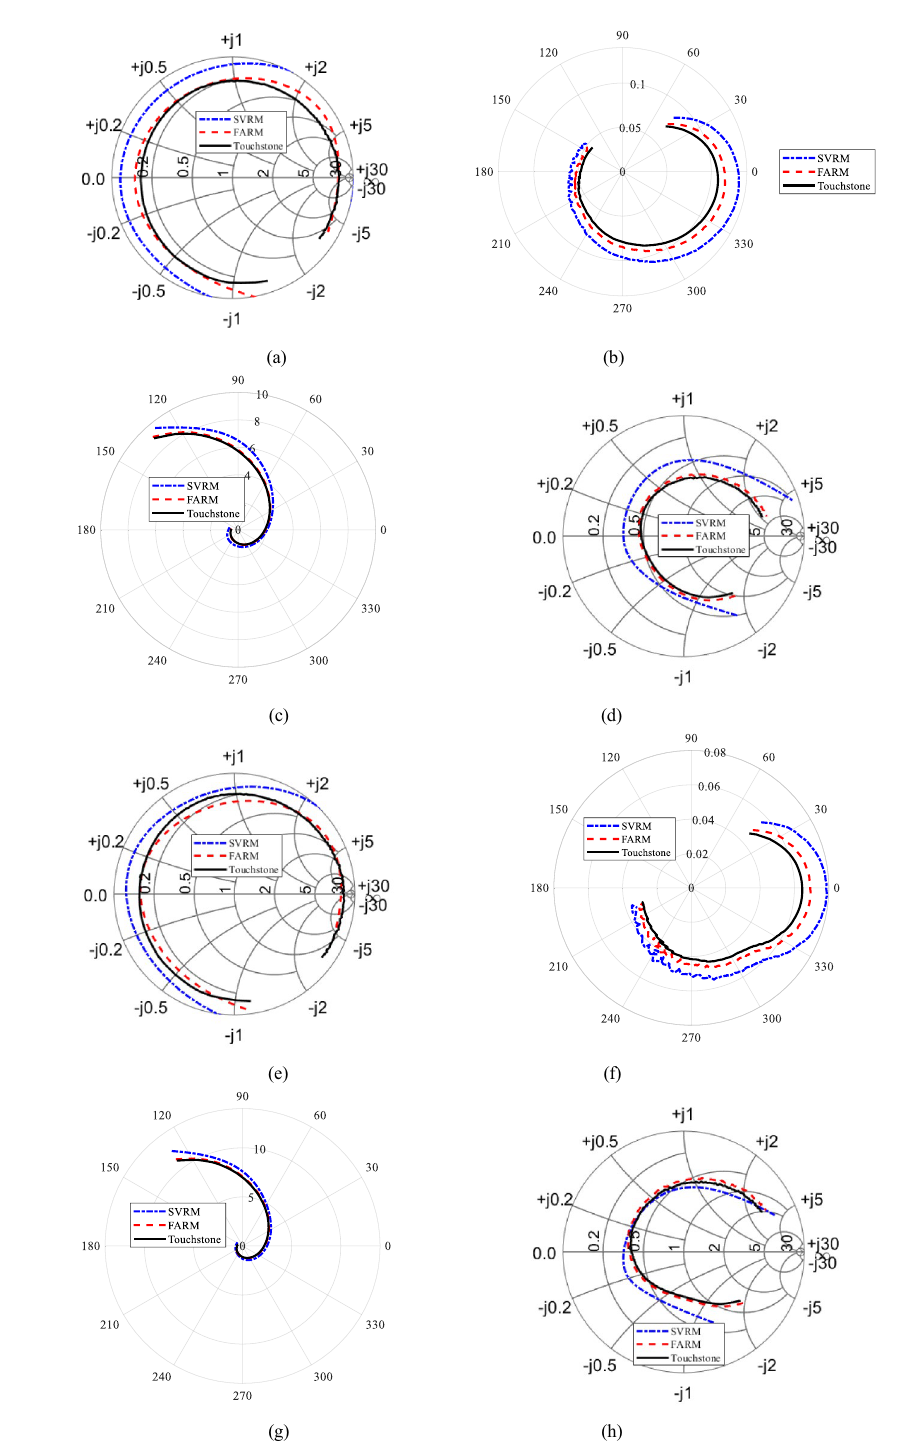
Figure 7. Transistor VMMK-1218: Smith chart (for reflection coefficient) and polar graphs (for transmission coefficient) of ( a – d ) S 11 , S 12 S 21 , S 22 at bias voltage V = 2 V and bias current I = 10 mA, ( e – h ) S 11 , S 12 S 21 , S 22 at V = 10 V and I = 50